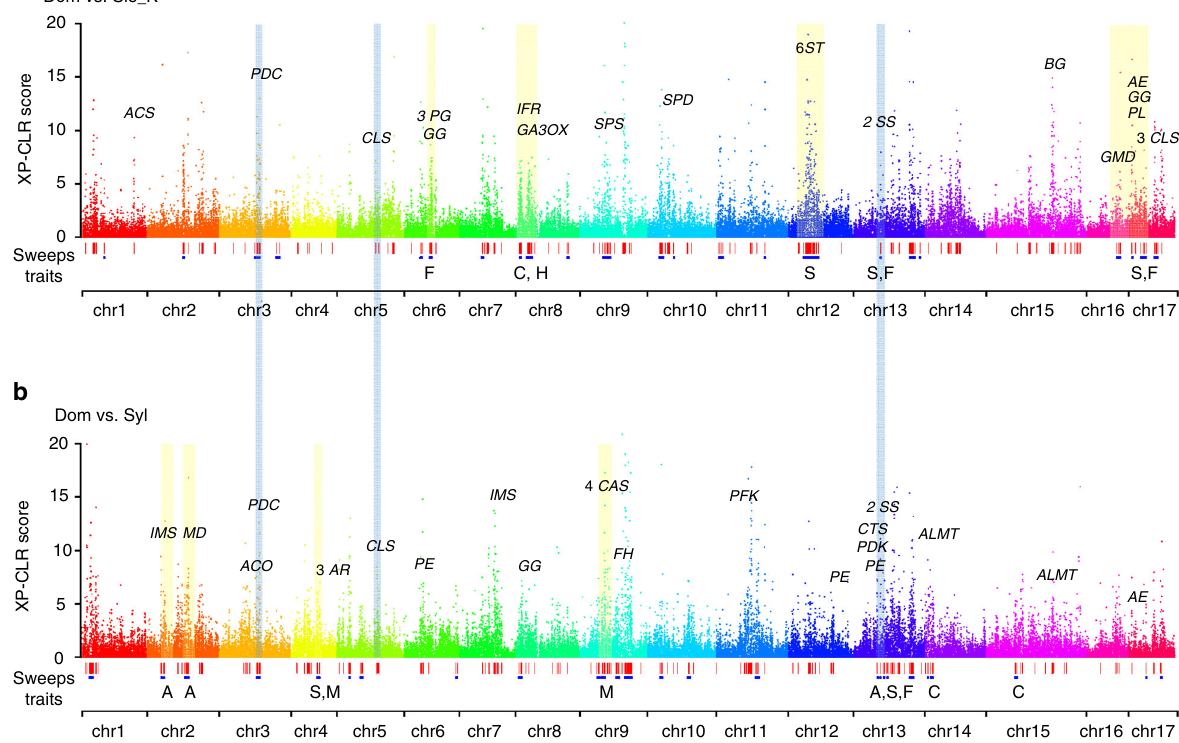
Fig. 3 Genome-wide distribution of selective sweeps in M. domestica . a Selective sweeps in M. domestica compared with M. sieversii in Kazakhstan. b Selective sweeps in M. domestica compared with M. sylvestris . XP-CLR scores are plotted across the 17 chromosomes in the apple genome with key functional enzyme genes labeled above the dot peaks. Red vertical boxes illustrate selective sweeps, and blue boxes represent local GO enriched regions with associated traits labeled below. Selective regions shared by both comparisons are shaded with light blue bars , while interesting regions only identi fi ed in one of the two comparisons are shaded with light yellow bars . Traits include fruit acidity (A), color (C), fi rmness (F), hormone (H), soluble sugar (S), and secondary metabolites (M). Gene abbreviations: ALMT aluminum-activated malate transporter, ACO 1-aminocyclopropane-1-carboxylate oxidase, ACS 1-aminocyclopropane-1-carboxylate synthase, AE aldose 1-epimerase, AR aldose reductase, BG beta-galactosidase, CAS cycloartenol